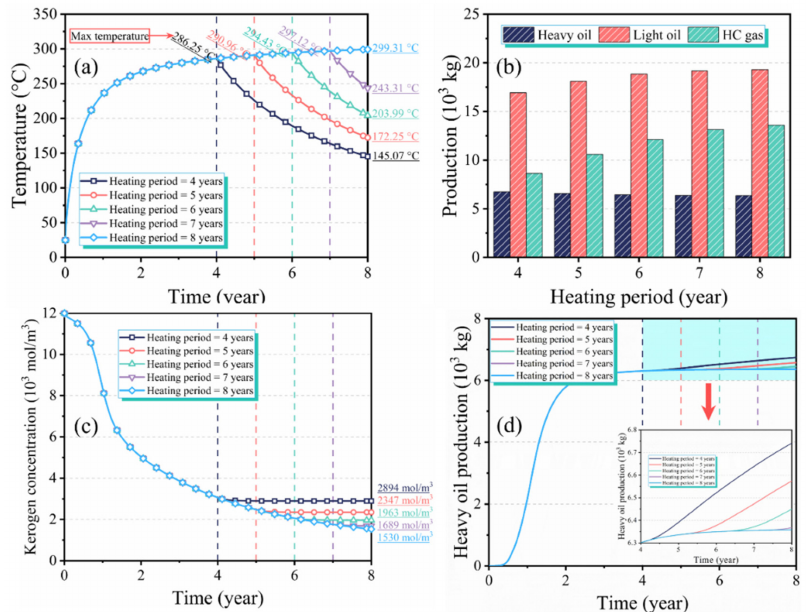
Figure 10. Effect of the heating period on: ( a ) average reservoir temperature; ( b ) cumulative production of fluid components; ( c ) the average concentration of kerogen; ( d ) production of heavy oil.